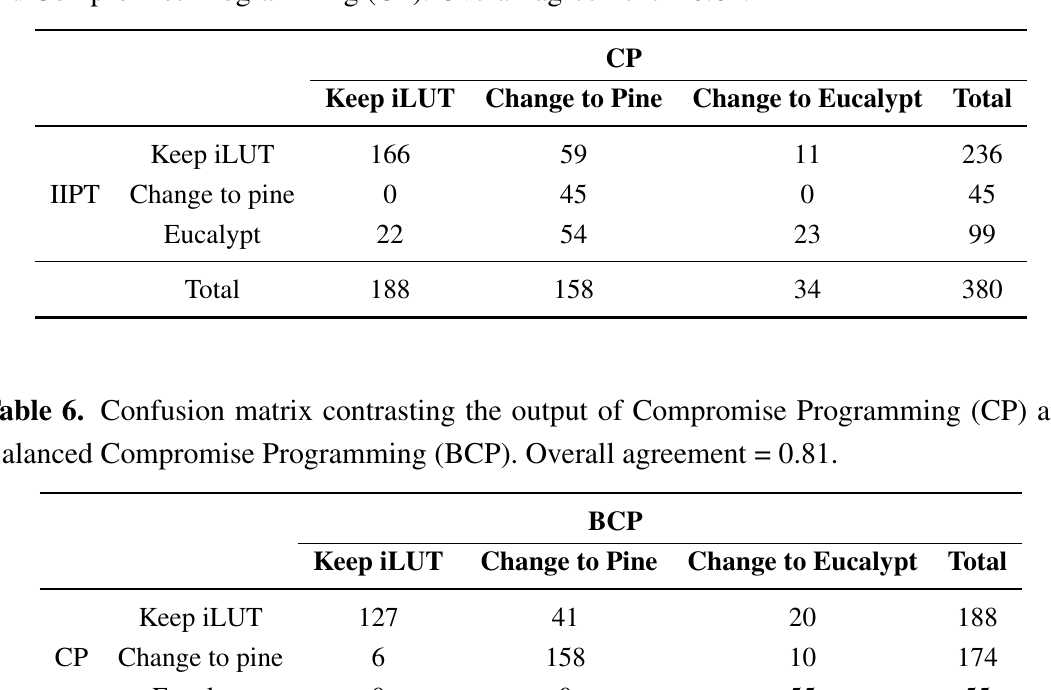
Table 5. Confusion matrix contrasting the output of Iterative Ideal Point Thresholding (IIPT) and Compromise Programming (CP). Overall agreement = 0.62.